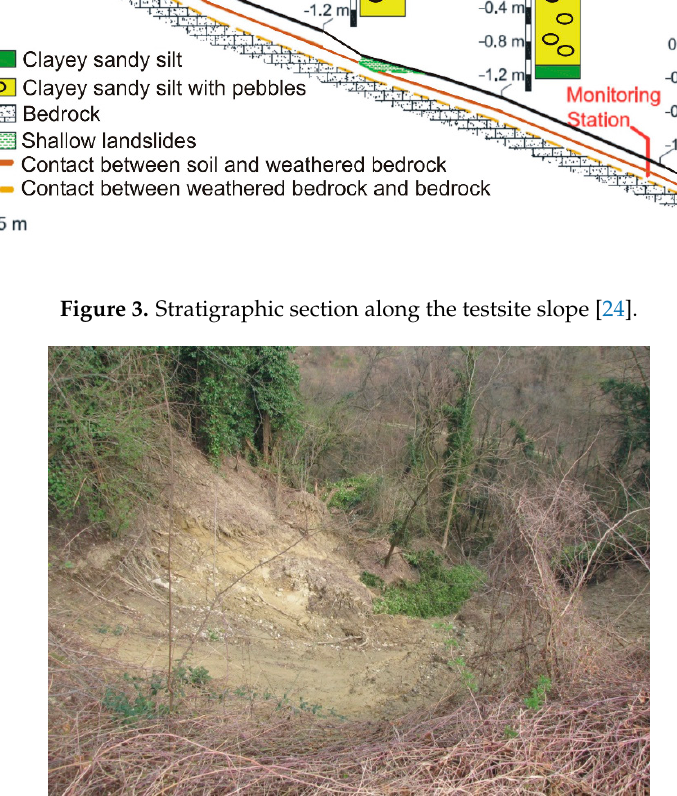
Figure 4. Field photograph of the shallow landslide triggered during the 28 February 2014–2 March 2014 event.